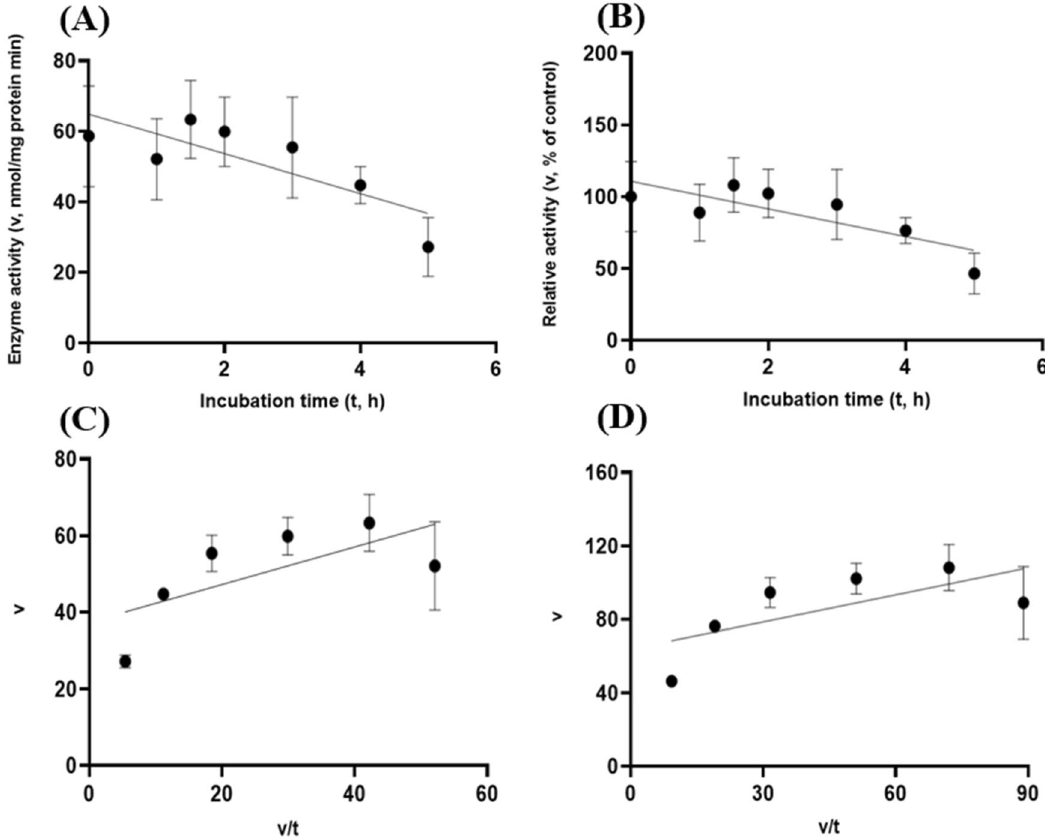
Figure 7. Experiment-2 of the gastric acidic pH effects (pH = 3.5) (with describing model parameter estimates ± SE ) on the heat-treated GH5-tCel5A1 activity over a 5-h period after the gastric pH buffer being mixed with the heat-treated crude GH5-tCel5A1 enzyme preparation prior to further incubation for measuring cellulase activity with the carboxymethyl cellulose (CMC) substrate buffer in presence of dithiothreitol (DTT) (5 mM) and N 2 gas purging for 15 min at 37 °C. (A) Exponential plot of the inhibition kinetic relationship between the heat-treated tCel5A1 activity [v, mean ± SE, n = 12at each time point, nmol/mg protein•min] and incubation time (t, h) under the gastric pH-3.5 conditions according to the exponential response model established as: Y = 61.859 ( ± 8.079 ) e ( − x ) , P < 0.0001 for the initial residual heat-treated GH5-tCel5A1 activity estimate; and P = 0.103 for the rate constant estimate; R 2 = 0.059 , n = 84; and alternatively, according to the linear response model established as y = 62.513 ( ± 7.345 ) − 8.451 ( ± 4.358 ) x , P < 0.0001 for the intercept; and P = 0.056 for the slope, r 2 = 0.064 , n = 84; (B) Exponential plot of the inhibition kinetic relationship between the relative heat-treated GH5-tCel5A1 activity (v, mean ± SE, n = 12at each time point, % of the control group measured at I c of 100.000 ± 24.352) at 0-min exposure to the gastric pH 3.5 incubation) and incubation time (t, h) under gastric pH 3.5 conditions according to the exponential response model established as: Y = 105.6 ( ± 13.791 ) e ( − x ) , P < 0.0001 for the initial residual heat-treated GH5-tCel5A1 activity estimate; and P = 0.103 for the rate constant estimate, R 2 = 0.059 , n = 84; and alternatively, according to the linear response model established as y = 106.7 ( ± 12.537 ) − 8.451 ( ± 4.358 ) x , P < 0.0001 for the intercept; and P = 0.056 for the slope, r 2 = 0.087 , n = 84; (C ) the Eadie-Hofstee linear plot between the heat treated GH5-tCel5A1 enzyme activity [v, mean ± SE, n = 12at each data point, nmol/mg protein•min] and the v/t ratio established as y = 20.321 ( ± 3.744 ) + 1.154 ( ± 0.105 ) x , P < 0.0001 for all the parameter estimates; r 2 = 0.649 , n = 72; and (D ) the Eadie-Hofstee linear plot between the relative heat-treated tCel5A1 enzyme activity (v, mean ± SE, n = 12at each data point, % of the control group measured at I c of 100.000 ± 24.352 at 0-min exposure to the gastric pH 3.5 incubation) and the v/t ratio established as y = 34.685 ( ± 6.391 ) + 1.153 ( ± 0.105 ) x , P < 0.0001 for all parameter estimates; r 2 = 0.650 , n = heat-treated version of the GH5-tCel5A1 cellulase by the intestinal trypsin (60 U/mL) at pH 6.5. Furthermore, GH5-p4818Cel5_2A had an estimated relative maximal enzyme activity inhibition I max = 87.76% with the IC 50 = 1.20 h by the intestinal trypsin (60 U/mL) at pH 6.5. Lastly, the target enzymes’ stability within the small intestinal luminal conditions with resistance to the exo- crine pancreatic chymotrypsin (20 U/mL) was also investigated. Similar to the preceding in vitro trypsin stability experiments, these target enzyme samples were incubated with chymotrypsin (20 U/mL at pH 6.5) with the N 2 gas purging treatment. GH5-tCel5A1 demonstrated cubic and linear patterns of responses ( P < 0.05) (Fig. 15A–B); while the heat-treated GH5-tCel5A1 cellulase only shown the cubic pattern of response ( P < 0.05) (Fig. 16A–B) under the small intestinal chymotrypsin (20 U/mL at pH 6.5) condition. Furthermore, GH5-p4818Cel5_2A